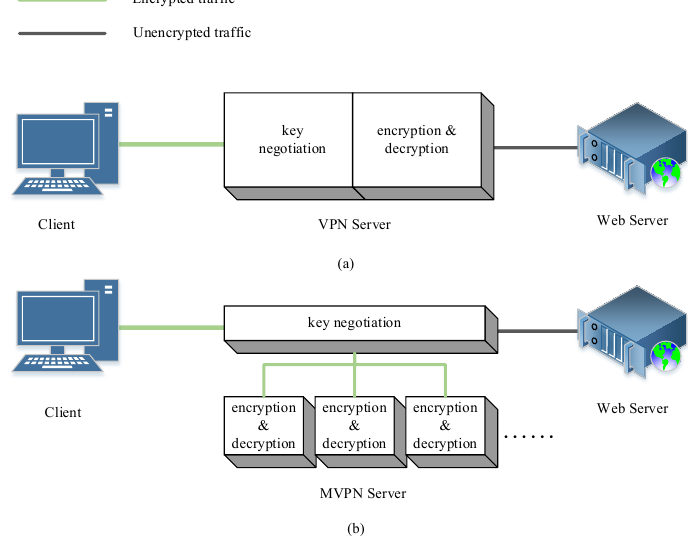
Figure 1. ( a ) Traditional VPN architecture, ( b ) MVPN